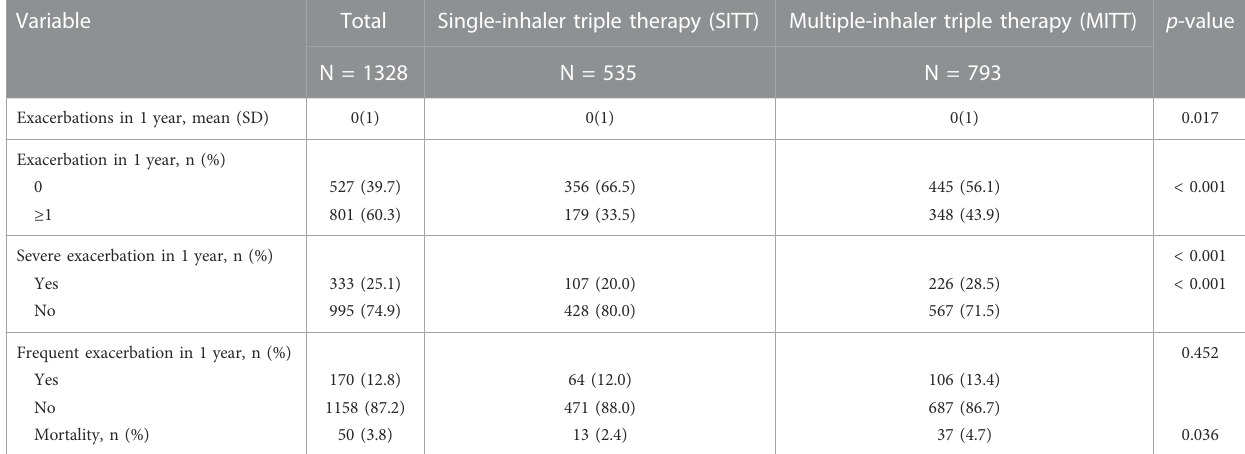
TABLE 3 Exacerbation rates and all-cause mortality during 12-month